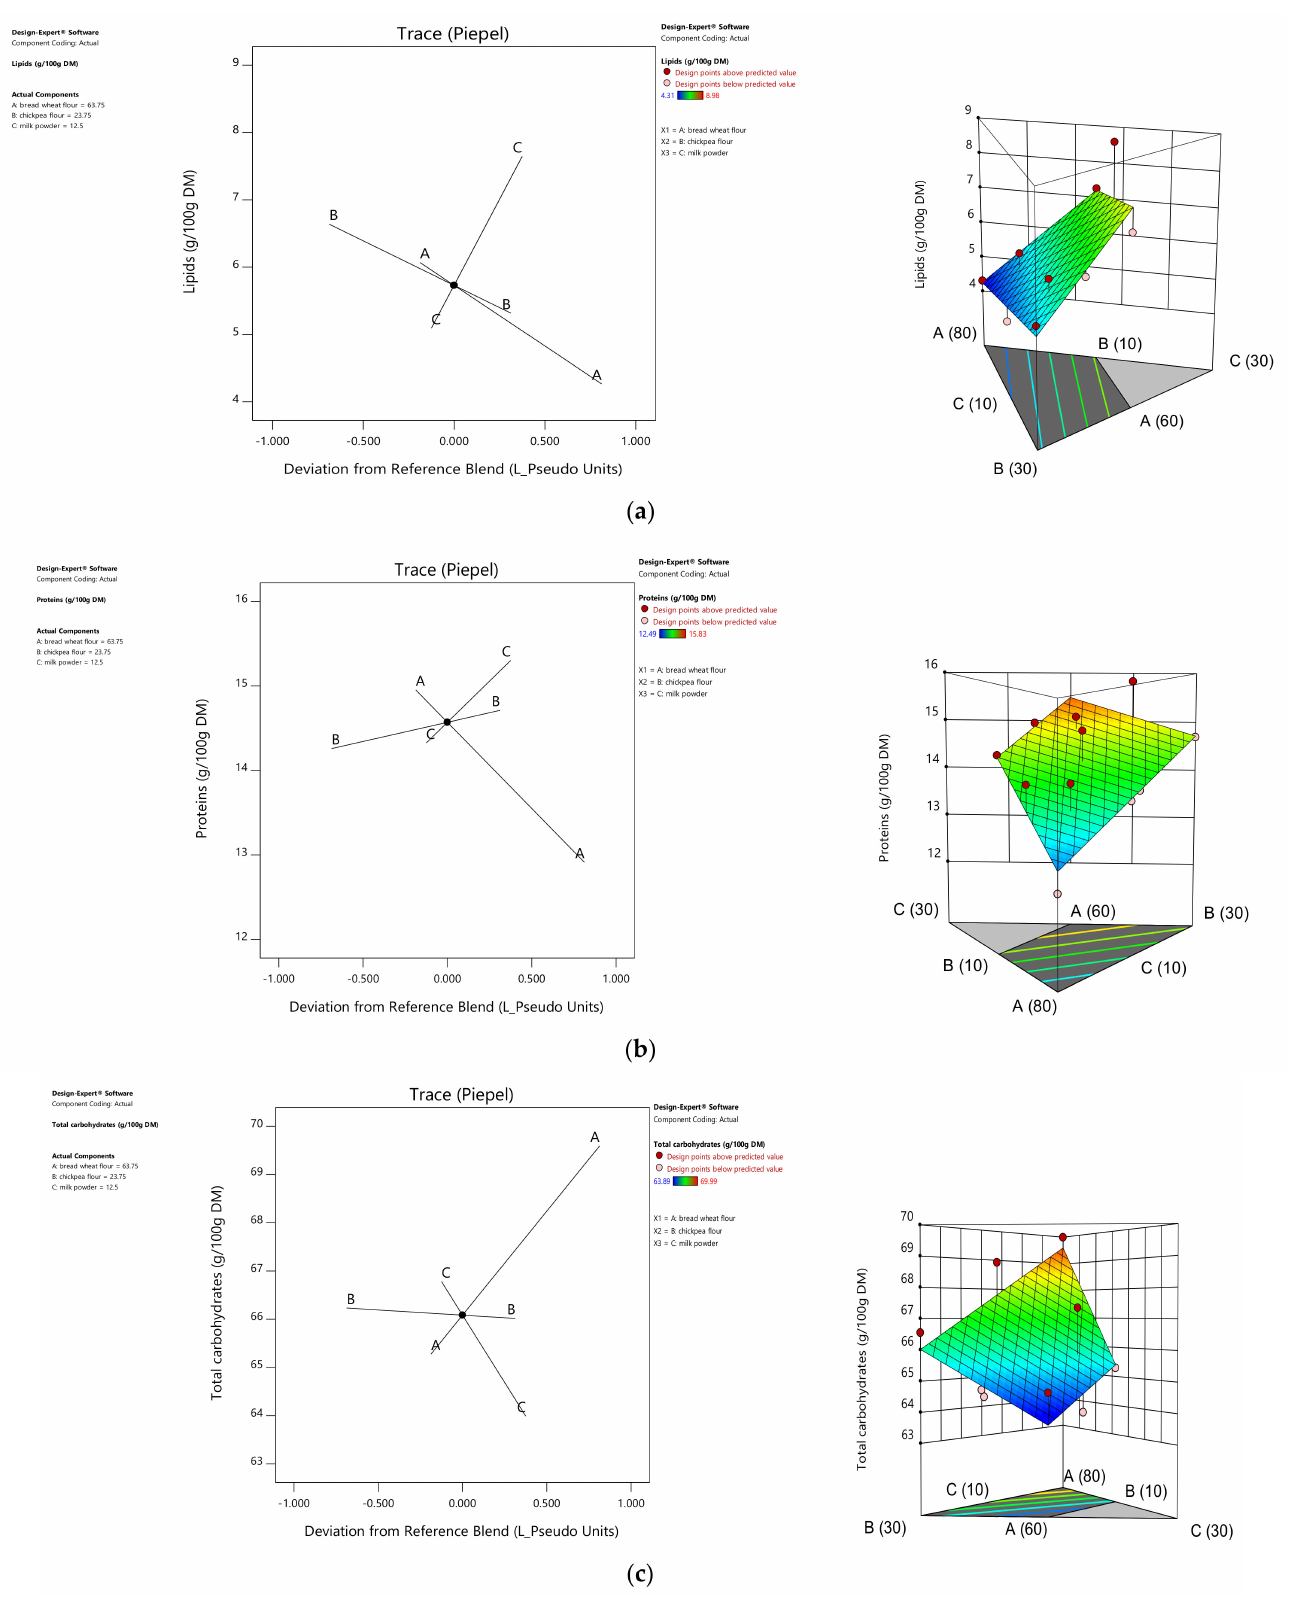
Figure 1. Trace plot curves and response surface (2D and 3D) presentations of lipid ( a ), protein ( b ), and total carbohydrate ( c ) variations in flour blends (A: Bread wheat, B: Chickpea, C: Milk